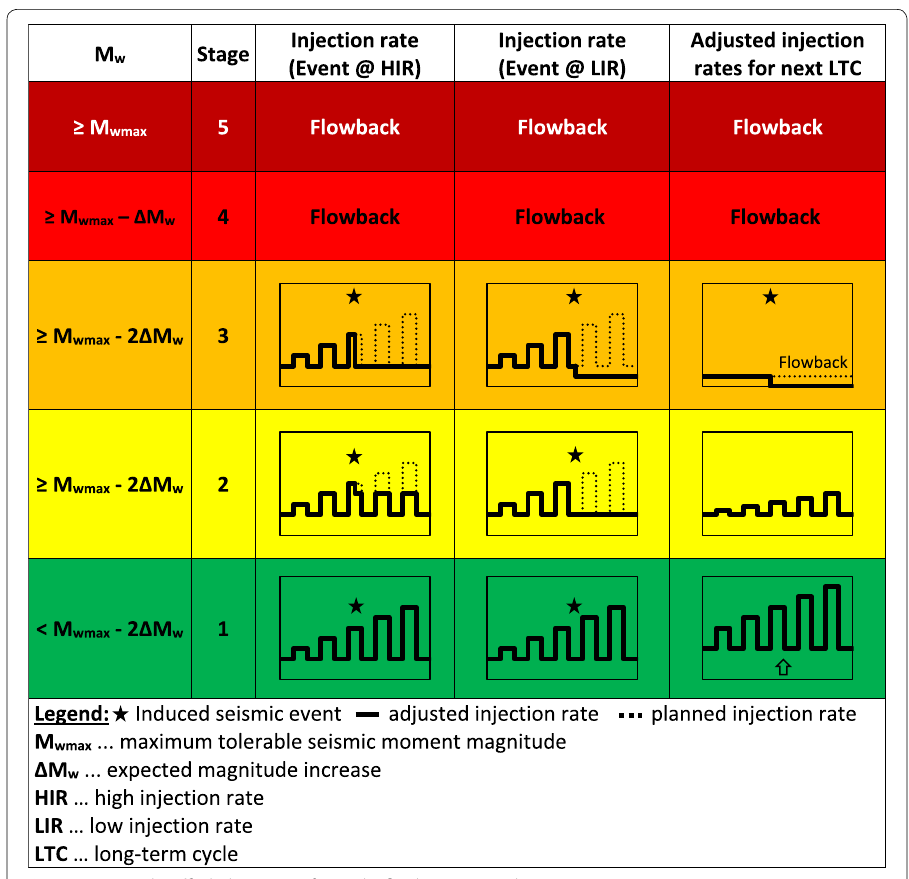
Fig. 7 Proposed traffic light system for cyclic fluid injection